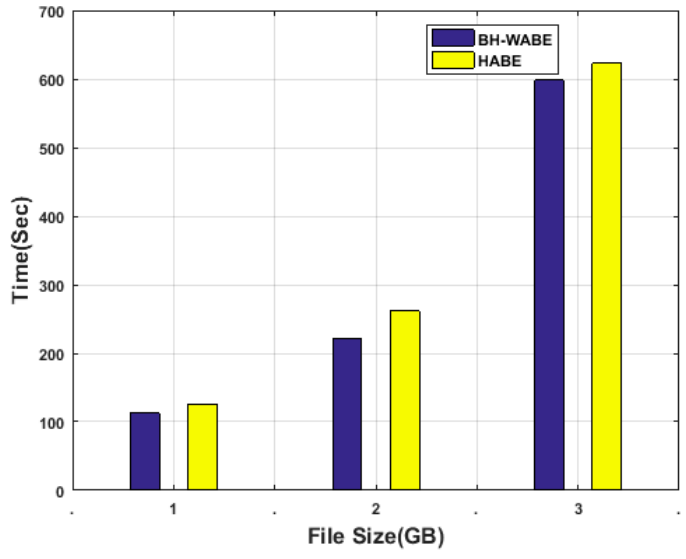
Figure 6. Computation cost of decryption.